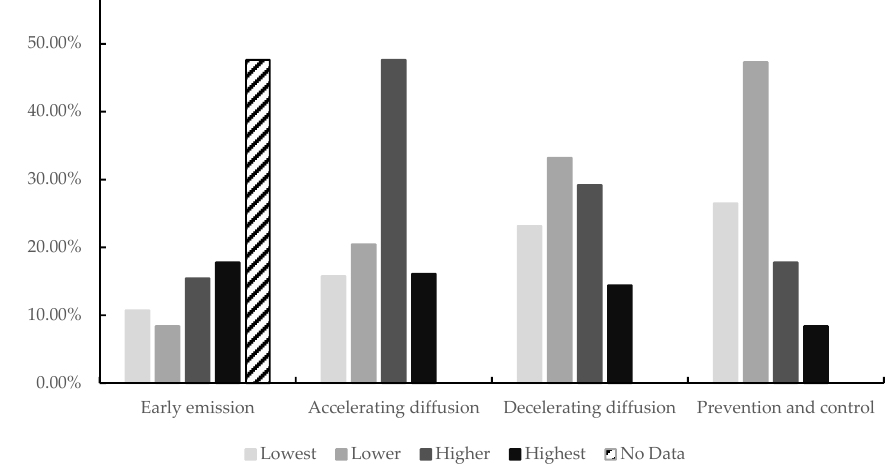
Figure 4. Proportion of the environmental risk perception during the COVID-19 epidemic.